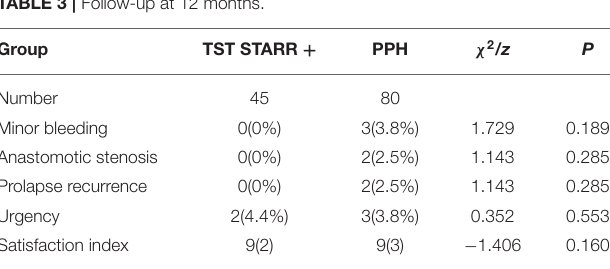
TABLE 3 | Follow-up at 12 months.